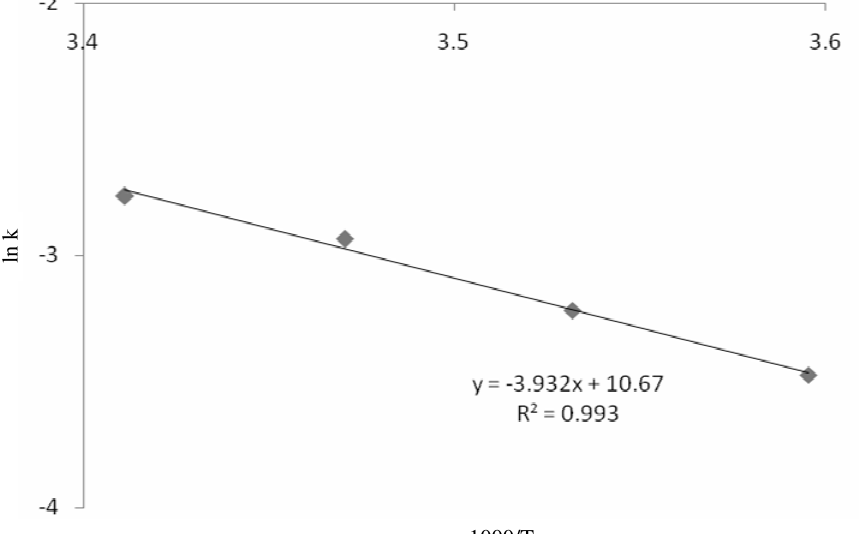
Figure 4. Arrhenius plot for photocatalytic degradation of Bismarck brown G on ZnO